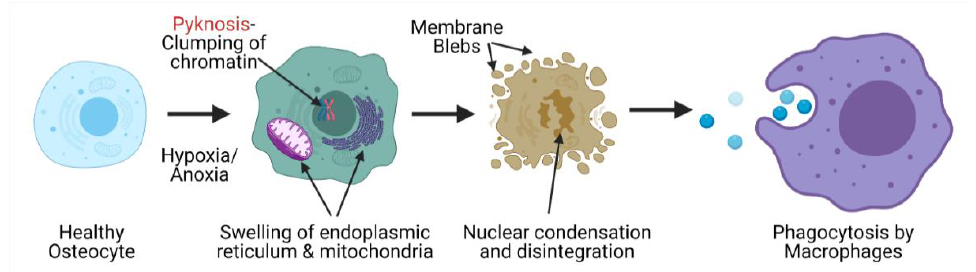
Figure 2. Mechanism of cell necrosis during avascular necrosis of the femoral head that leads to the clearance of osteocytes from bone lacunae, a confirmatory histological signature of avascular necrosis.